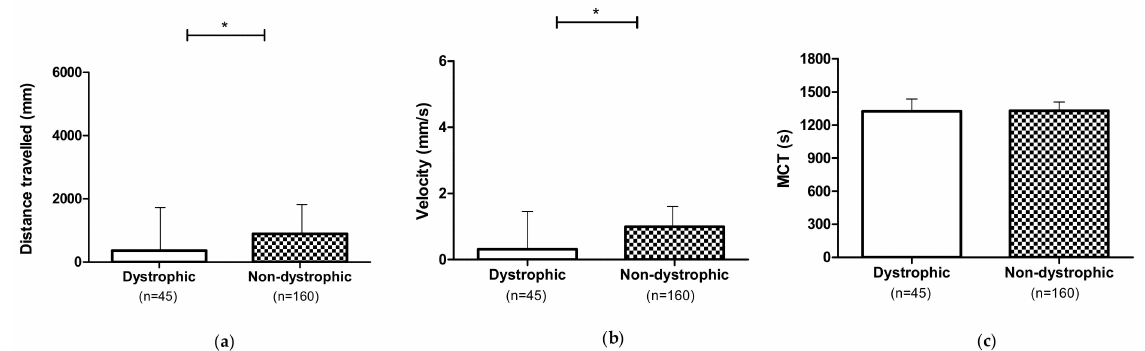
Figure 2. Locomotor performances of untreated (0 mg L − 1 ) dystrophic and non-dystrophic larvae: ( a ) Distance travelled; ( b ) Velocity; ( c ) MCT. Data are given as mean and standard error. (* p ≤